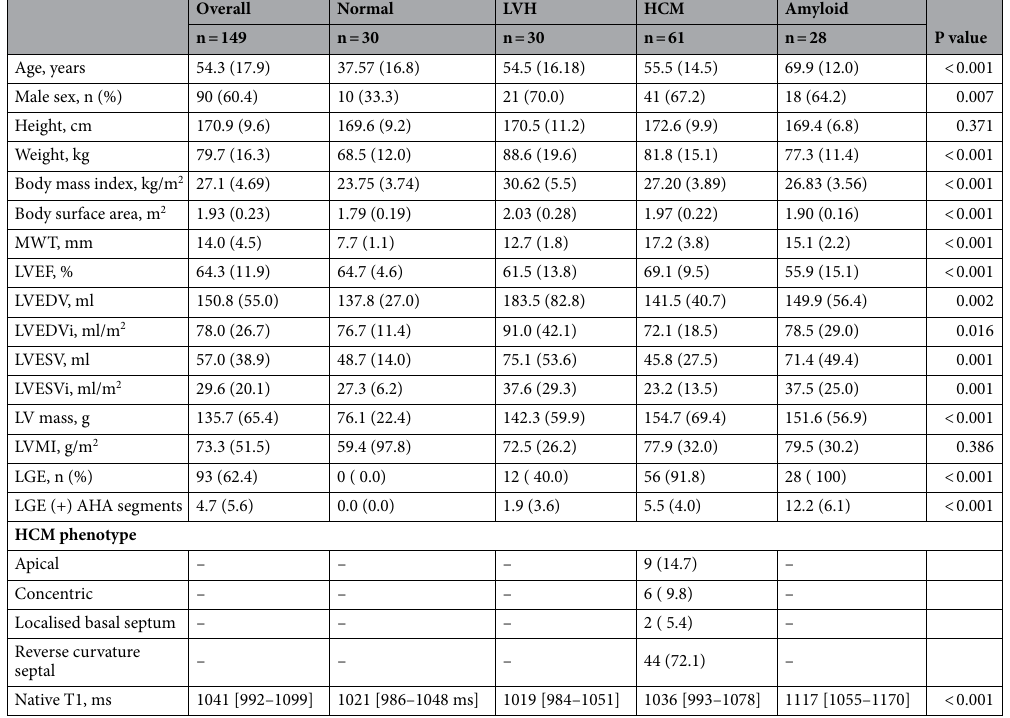
Table 1. xxx. AHA American Heart Association, HCM hypertrophic cardiomyopathy, LGE late gadolinium enhancement, LV left ventricle, LVEDVi left ventricular end diastolic volume index, LVEF left ventricular ejection fraction, LVESVi left ventricular end systolic volume index, LVH left ventricular hypertrophy, LVMI left ventricular mass index, LVSVi left ventricular stroke volume index, MWT maximal wall thickness;